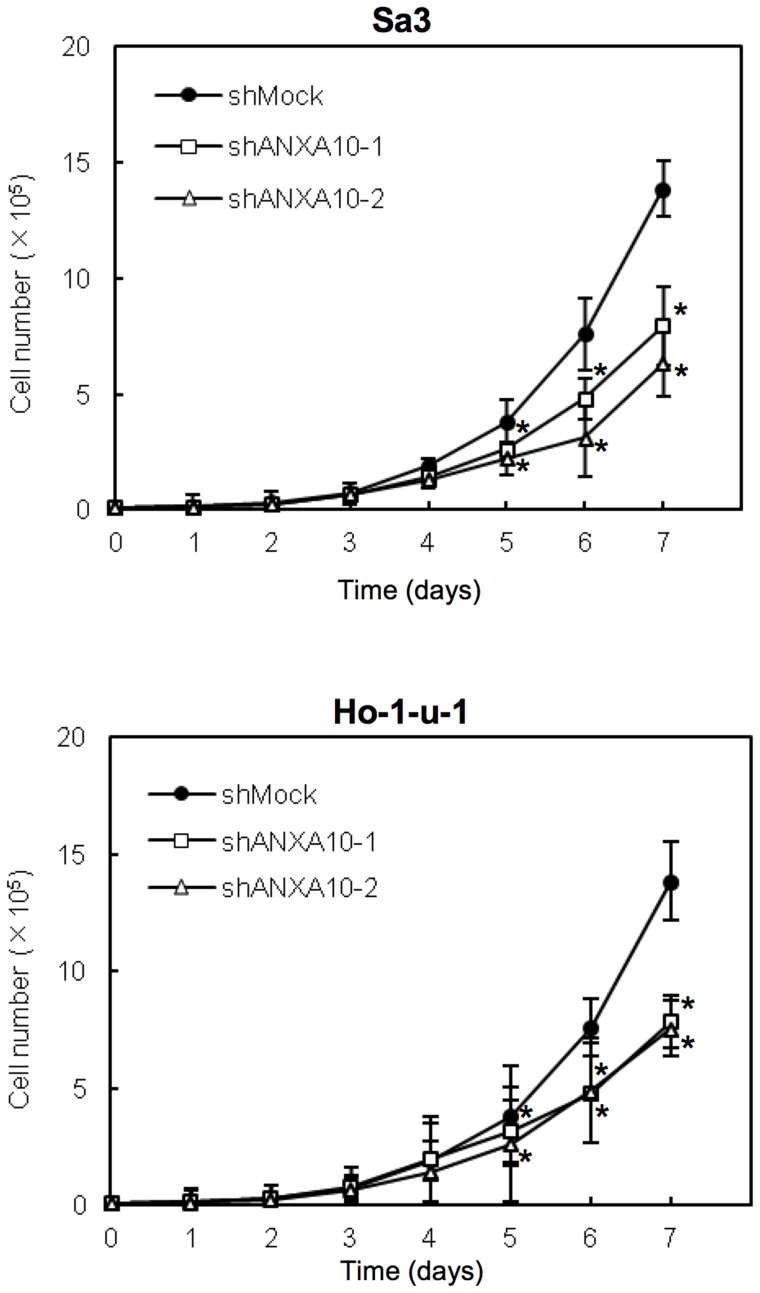
Effect of ANXA10 knockdown in shANXA10-transfected cells.To determine the effect of shANXA10 on cellular proliferation, shANXA10- and shMock-transfected cells are seeded in 6-well plates at a density of 1×104 viable cells/well. Both transfectants were counted on 7 consecutive days. The cellular growth of shANXA10-transfected cells (Sa3- and Ho-1-u-1-derived transfectants; 2 clones each) is significantly inhibited compared with shMock-transfected cells after 7 days (168 hours). The results are expressed as the means ± SEM of values from three assays. The asterisks indicate significant differences between the shANXA10- and shMock-transfected cells (*p<0.05; Mann-Whitney U test).